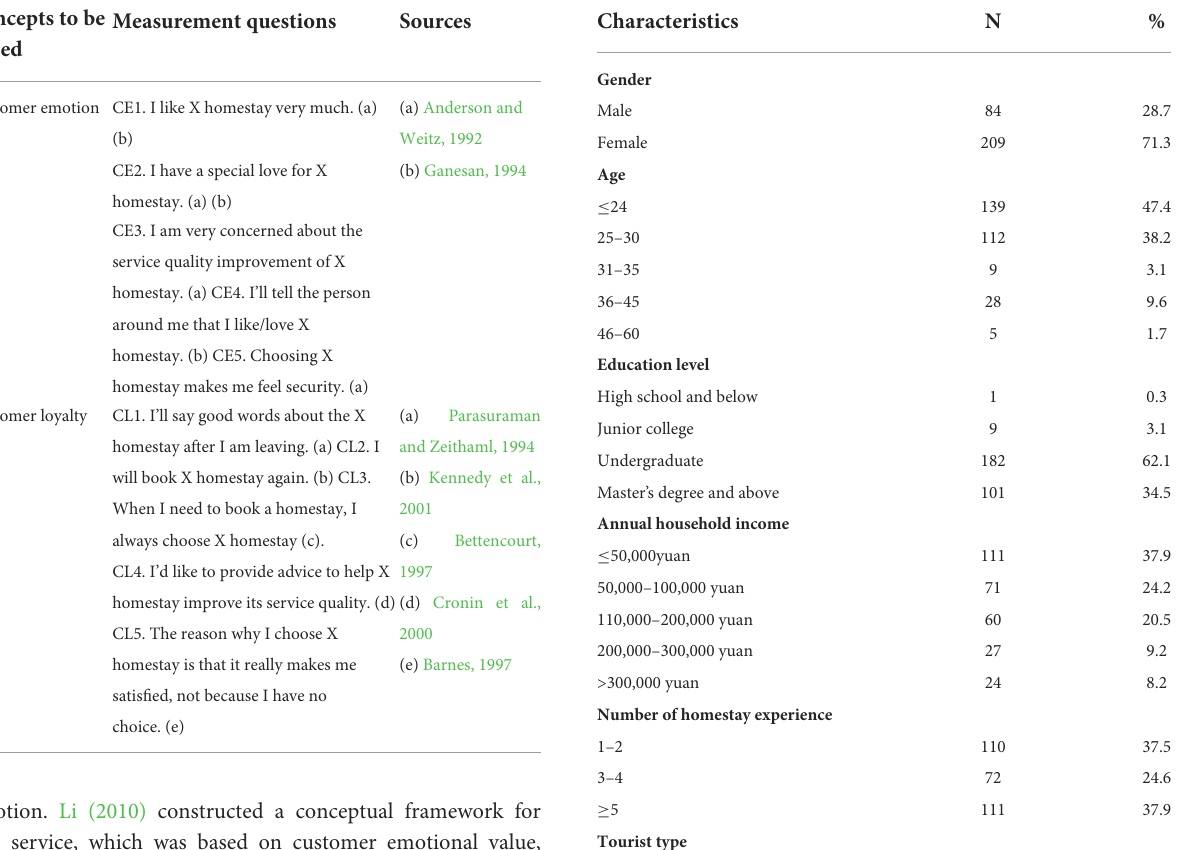
TABLE 3 Measurement scales of step two. TABLE 4 Sample profile ( n =